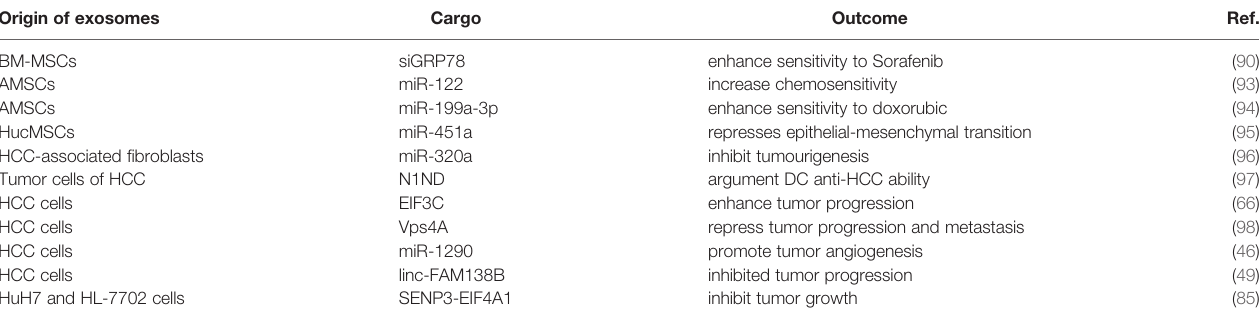
TABLE 2 | Exosomes as vehicle for the delivery of therapeutic